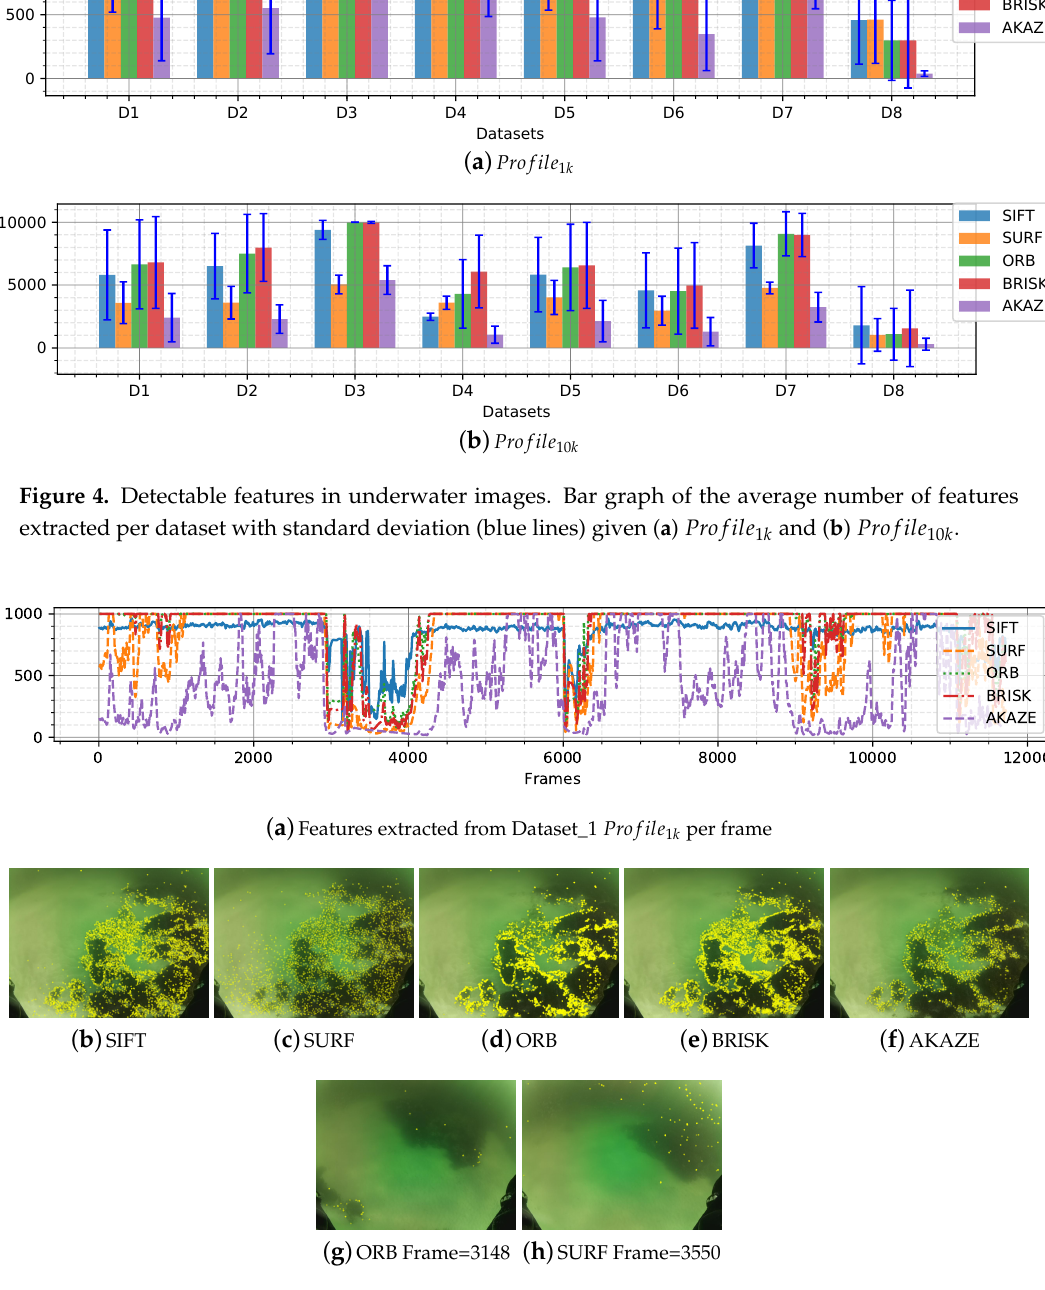
Figure 5. Detail of features extracted from Dataset_1. ( a ) features per frame. ( b – f ), features extracted with common feature extractors over the frame 710. ( g , h ) example of frames where the number of extracted features is